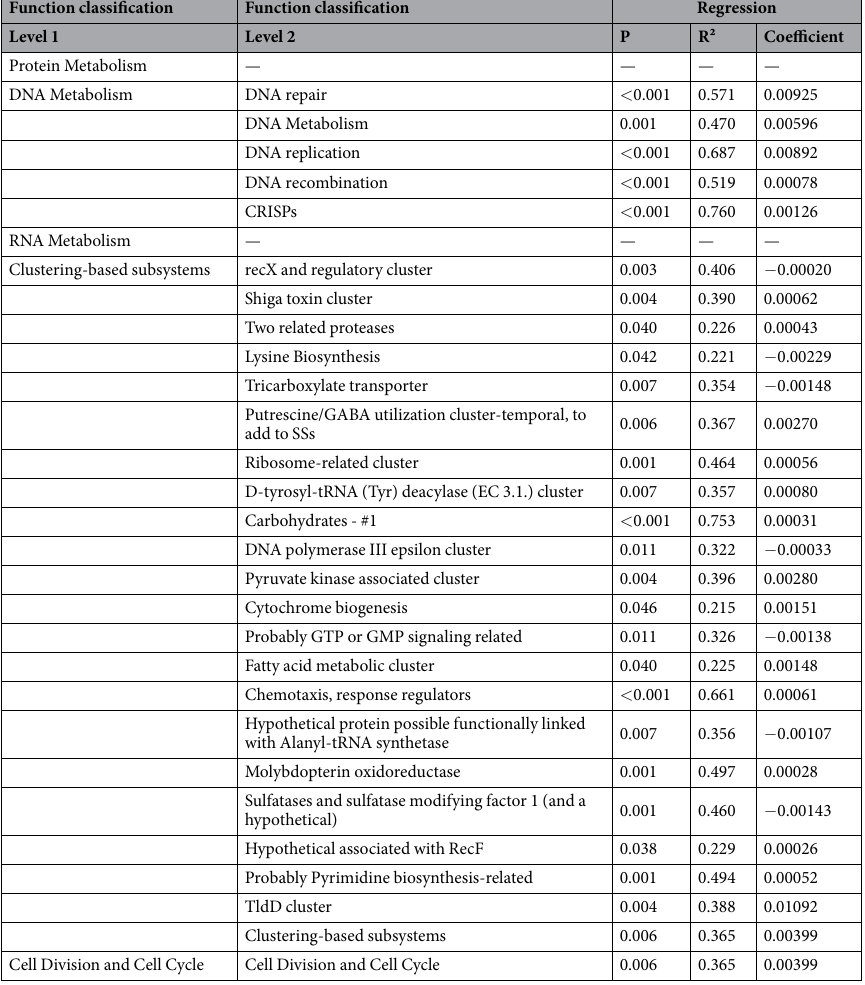
Table 1. Functional abundance analysis of level 2 under functional gene level 1 (SEED database) which had increasing correlation with incubation time. Only classification levels having P < 0.05 were